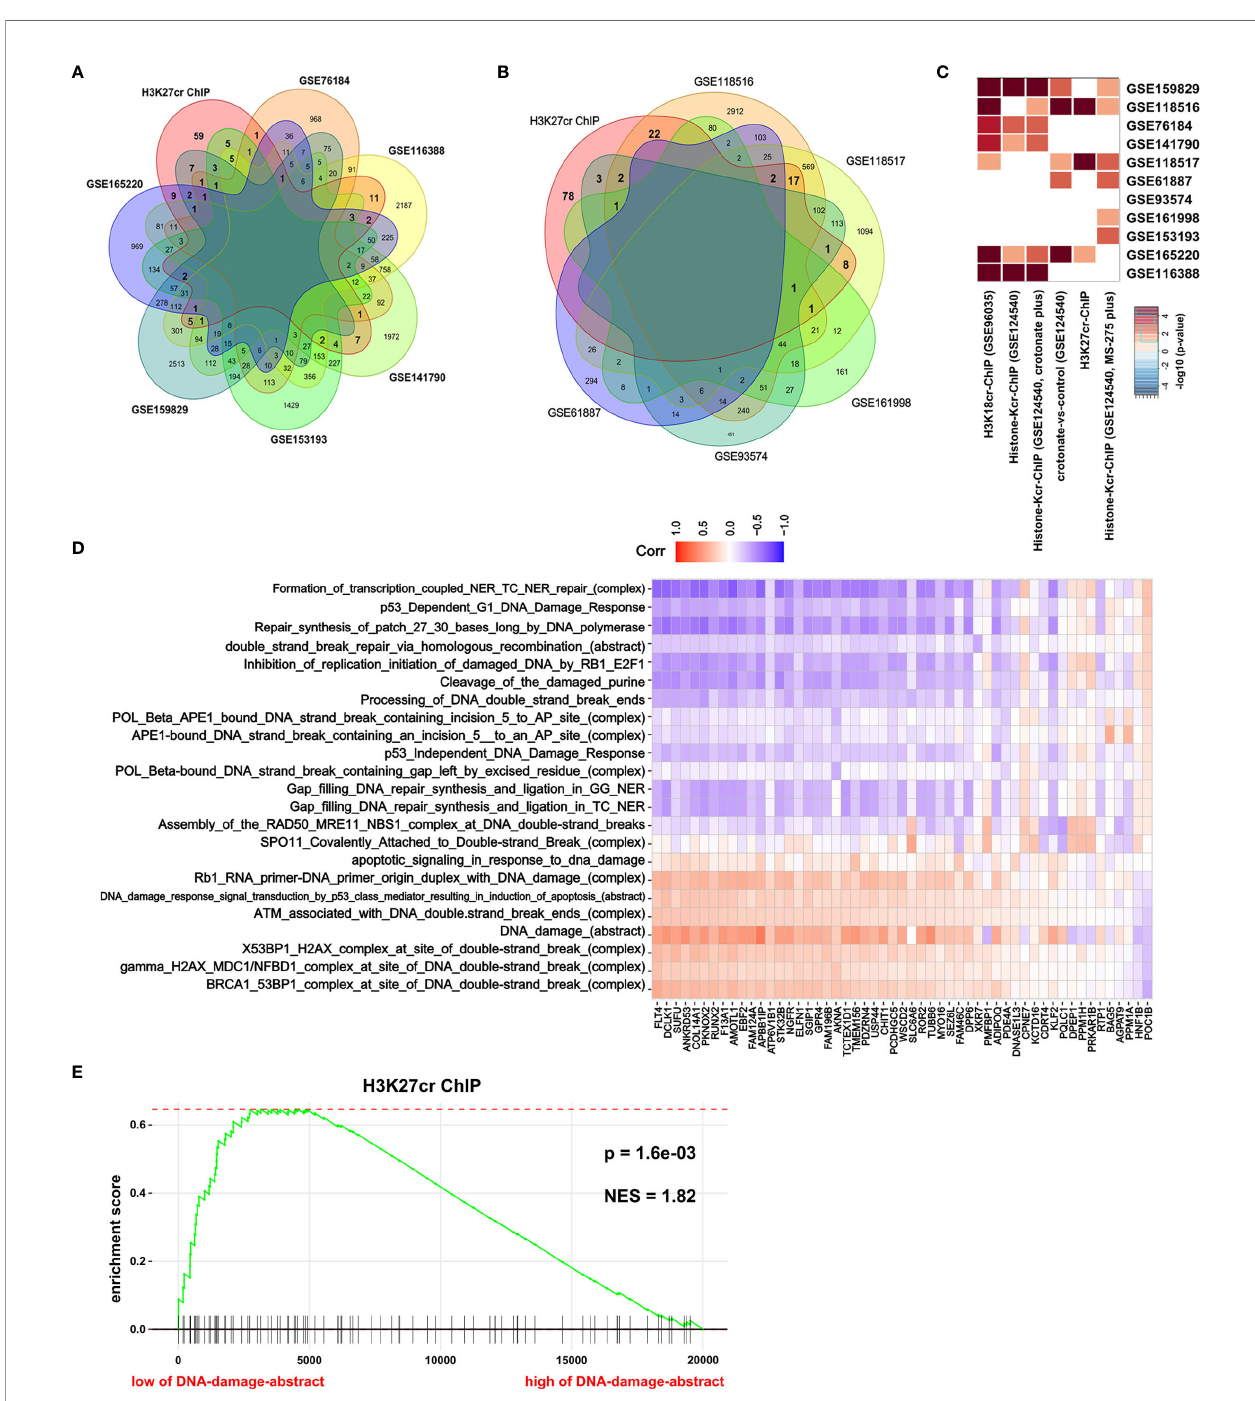
FIGURE 3 | H3K27cr is related to DNA damage in colon cancer. (A, B) The overlay of genes with H3K27cr enrichment on their promoter regions ( − 5 kb, +1 kb) and genes with expression change (fold-change >2) during ionizing radiation (IR) (A) or VP16 (B) treatment. (C) Heat map showing the genes with promoter occupied by histone crotonylation involved in multiple gene sets induced by IR or VP16 treatment in Fisher ’ s exact test. The color intensity indicates the negative base 10 logarithm of the p - value. The white spaces meant that P > 0.05. (D) Heat map showing the association between the expression of genes with H3K27cr enrichment on their promoter regions ( − 5 kb, +1 kb) and the value of DNA-damage-related complexes and abstract processes of paradigm-inferred pathway levels (IPLs) in Pearson correlation analysis. The color intensity indicates the value of the correlation coef fi cient. Blue indicates a negative correlation, and red indicates the opposite. (E) Gene Set Enrichment Analysis enrichment score curve showing that genes with promoter occupied by H3K27cr were enriched in colon cancer patients with a low level of DNA damage abstract in paradigm IPLs. The green curve indicates the enrichment